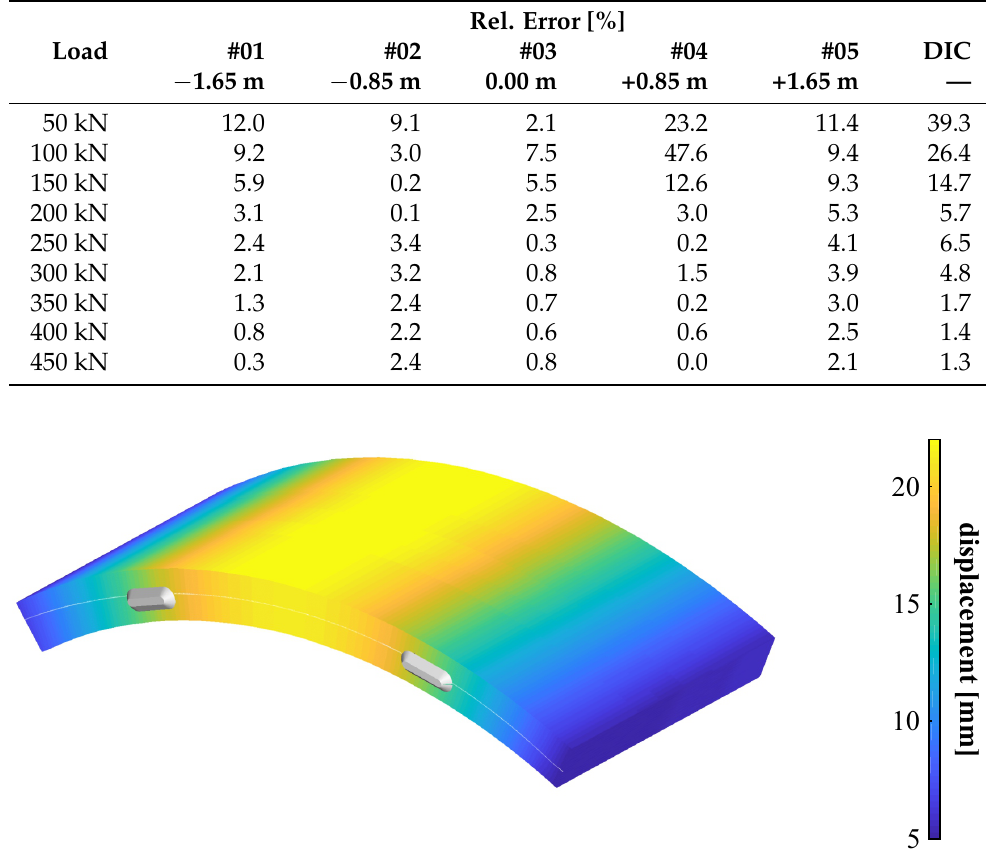
Figure 19. Areal displacement map of tunnel segment derived from DFOS at highest load